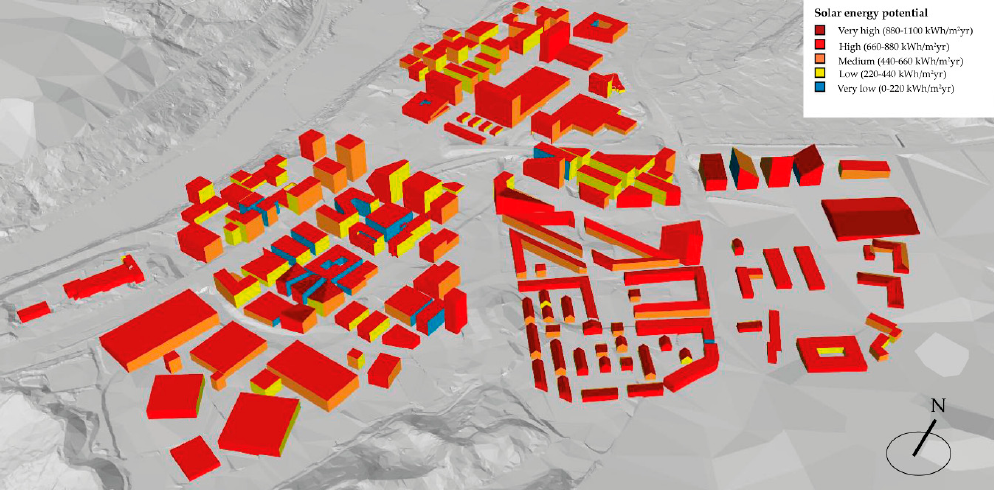
Figure 13. Three-dimensional visualization of the solar map for feasibility study I. Figure 14. Three-dimensional visualization of the solar map for feasibility study I.